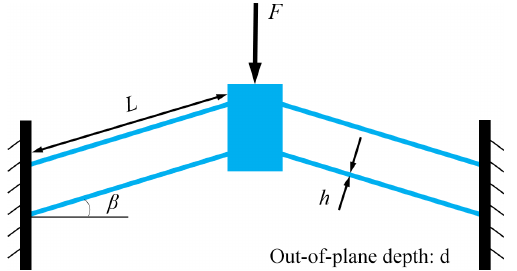
Figure 2. Conventional bistable compliant mechanism with four inclined fixed-guided